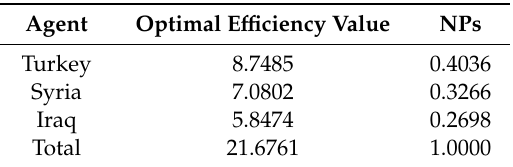
Table 3. Optimal e ffi ciency value and the agents’ negotiation powers (NPs) based on data envelopment analysis (DEA) in the Euphrates River